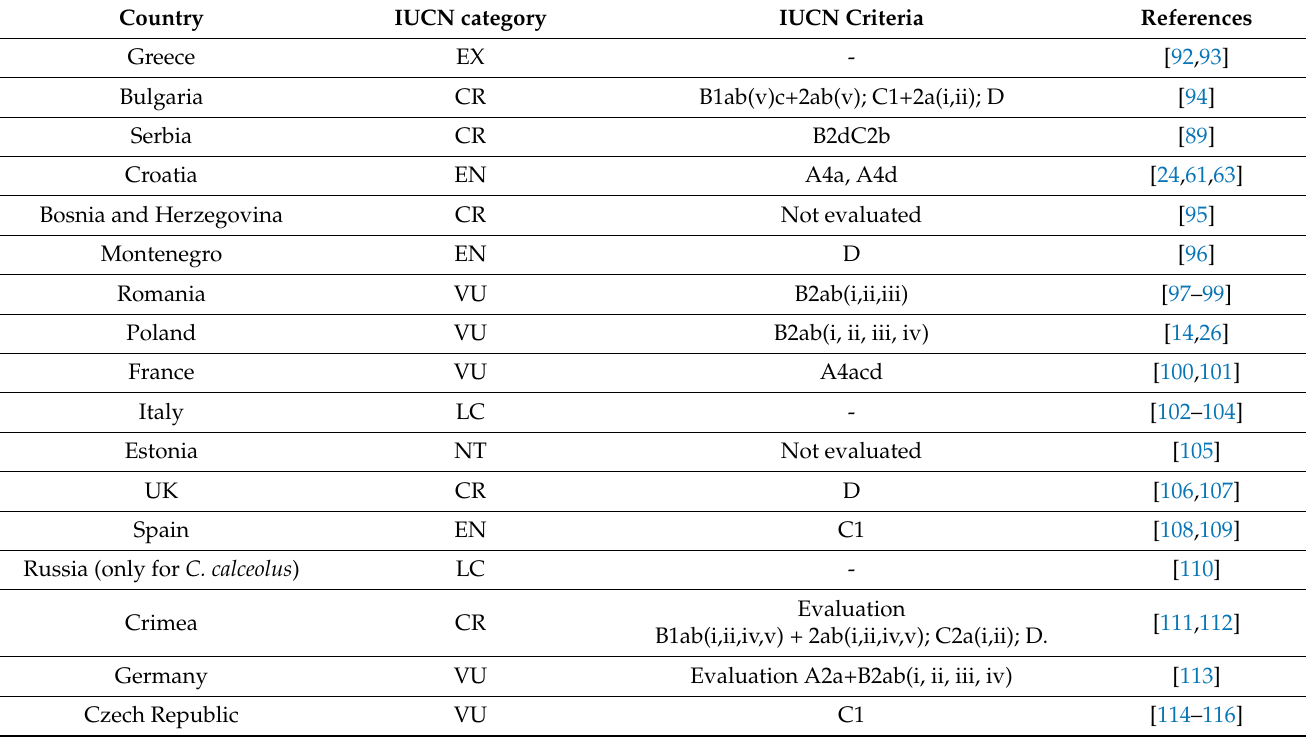
Table 1. The IUCN threat category of Cypripedium calceolus for all European